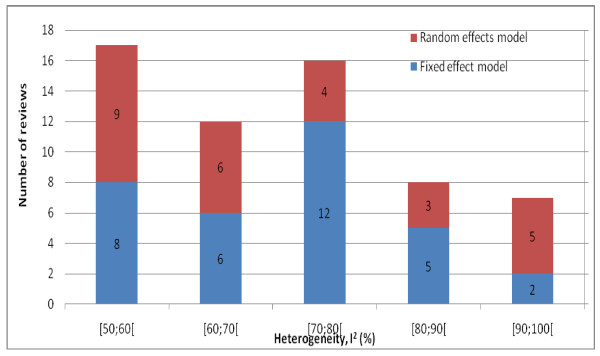
Choice of model, reviews grouped by I2.